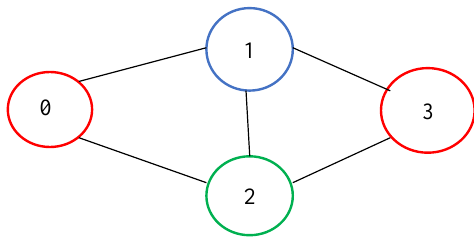
Figure1: An example of 3-colourable graph The neighbouring information of the vertices in the above graph is stored in the matrix created in Table 1.